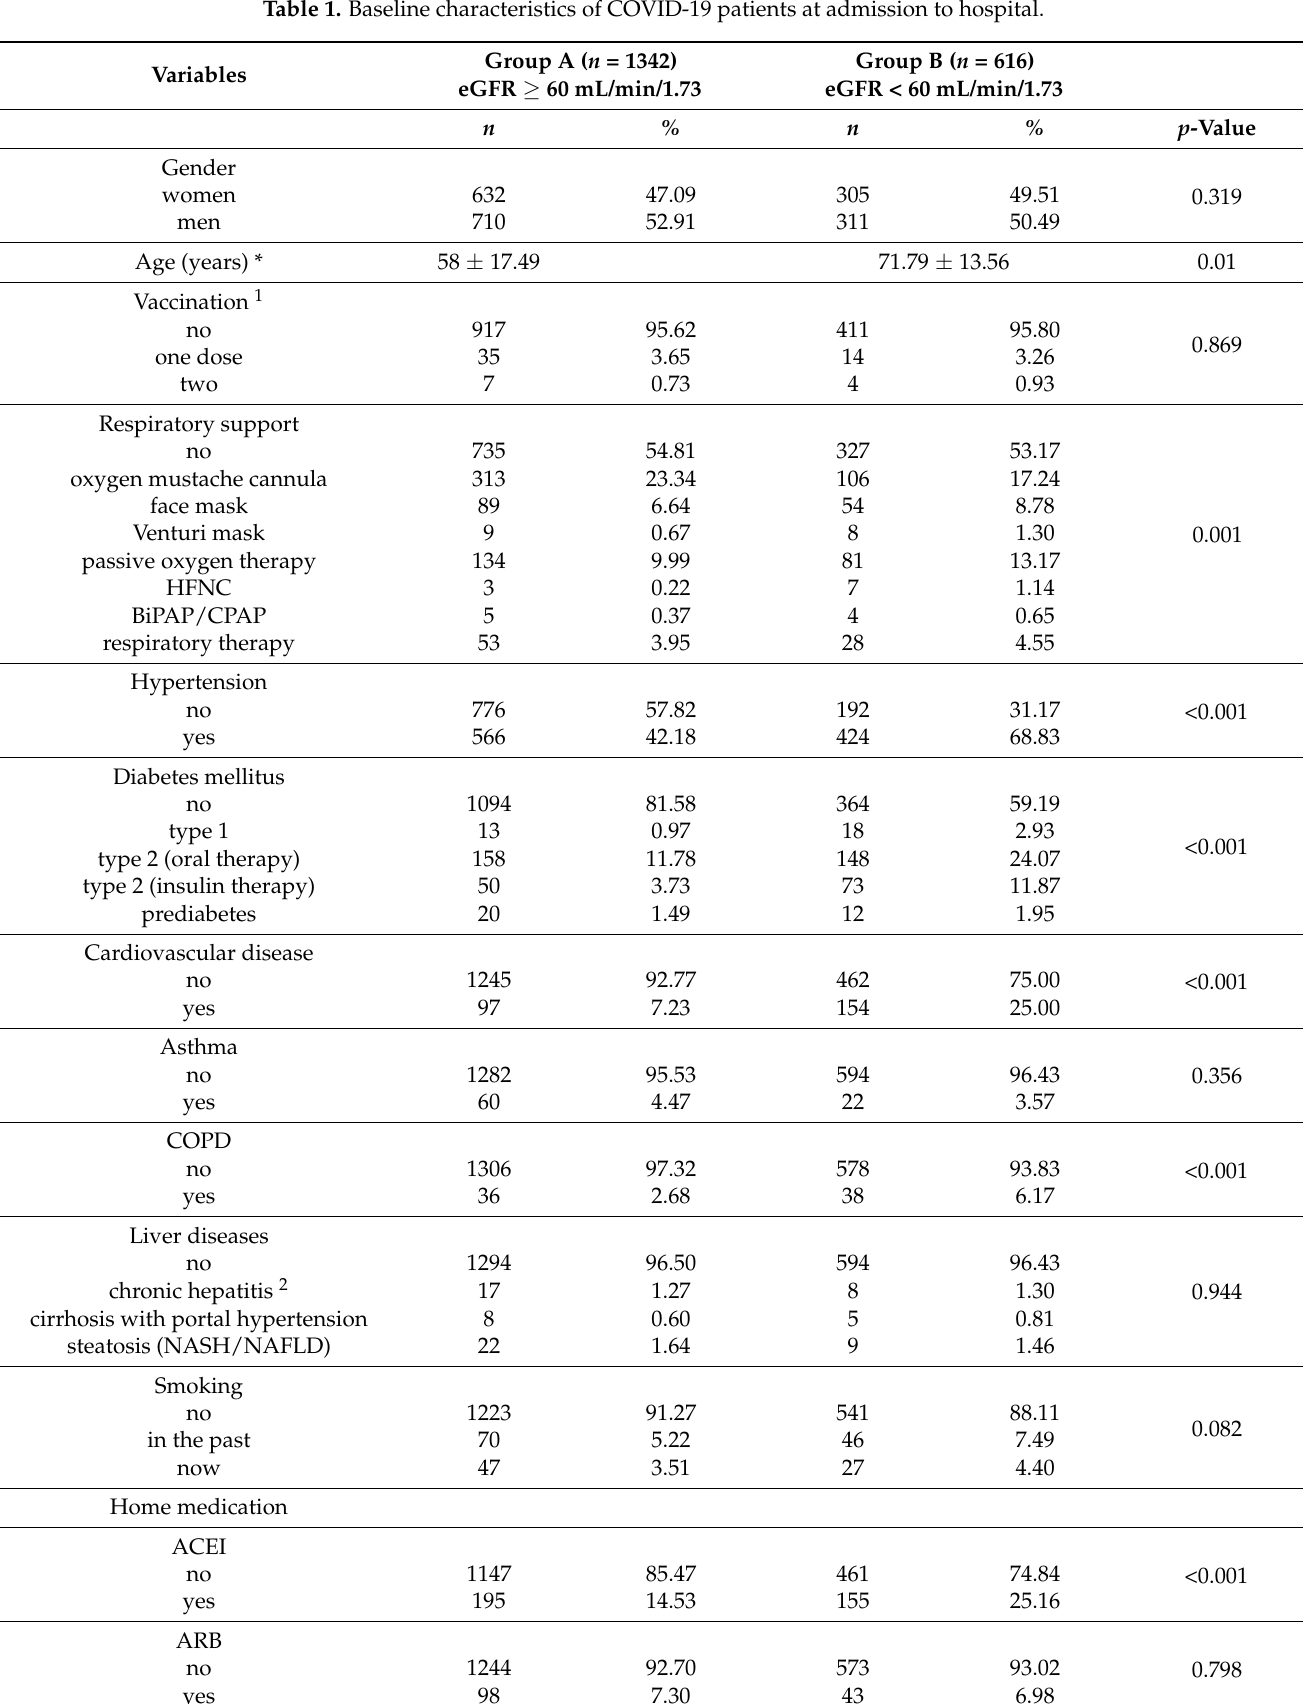
Table 1. Baseline characteristics of COVID-19 patients at admission to